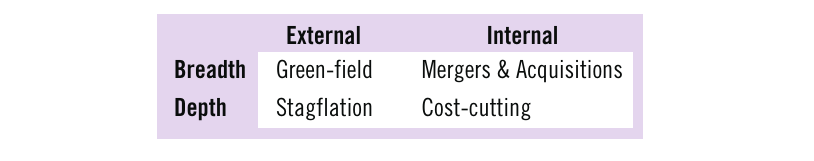
Table 1 – Regimes of Differential